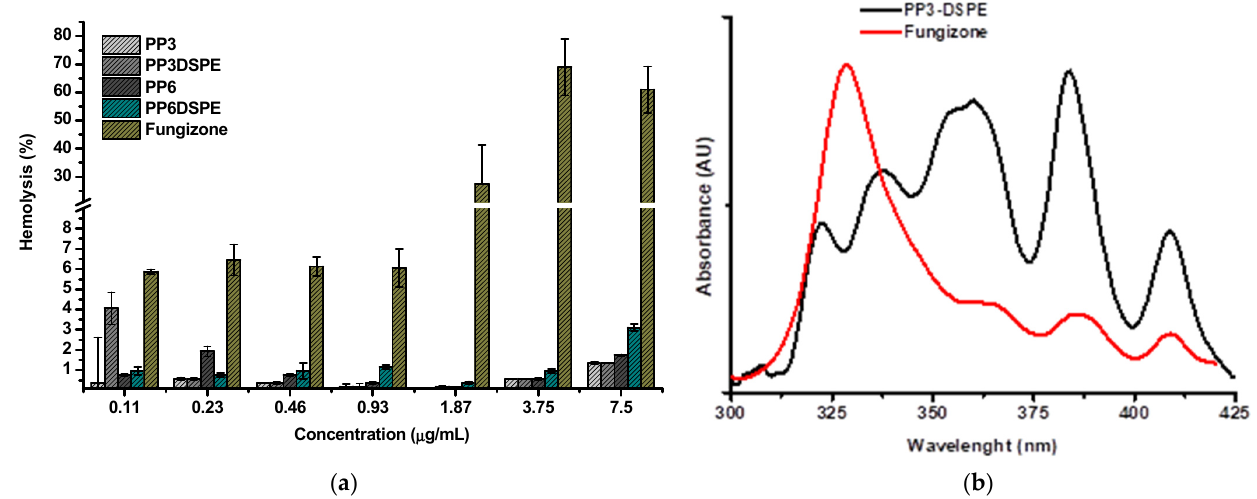
Figure 7. Erythrocyte toxicity of AmB-loaded PMs in comparison with commercial AmB formulation ( a ). ( b ) Aggregation state of AmB in Fungizone ® and a micellar formulation obtained using PP3-DSPE as a polymeric precursor.